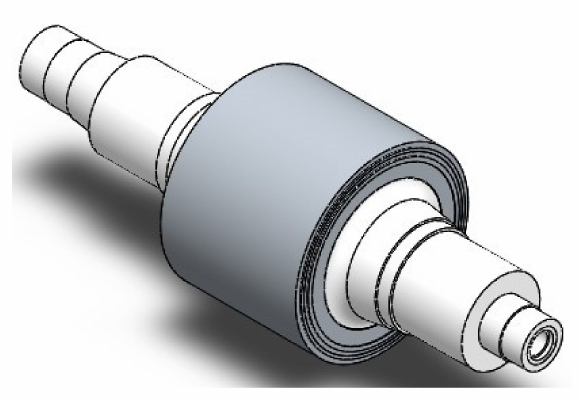
Figure 3. Three dimensional model of extrusion